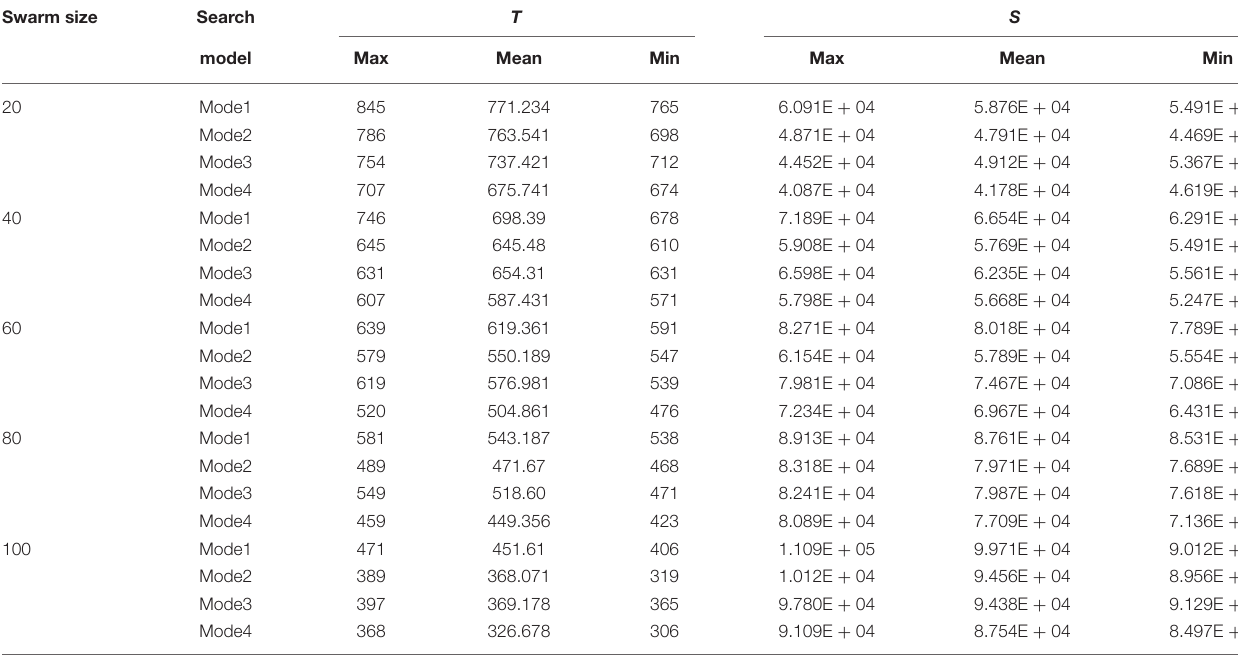
TABLE 4 | System performance comparison statistics table of four search